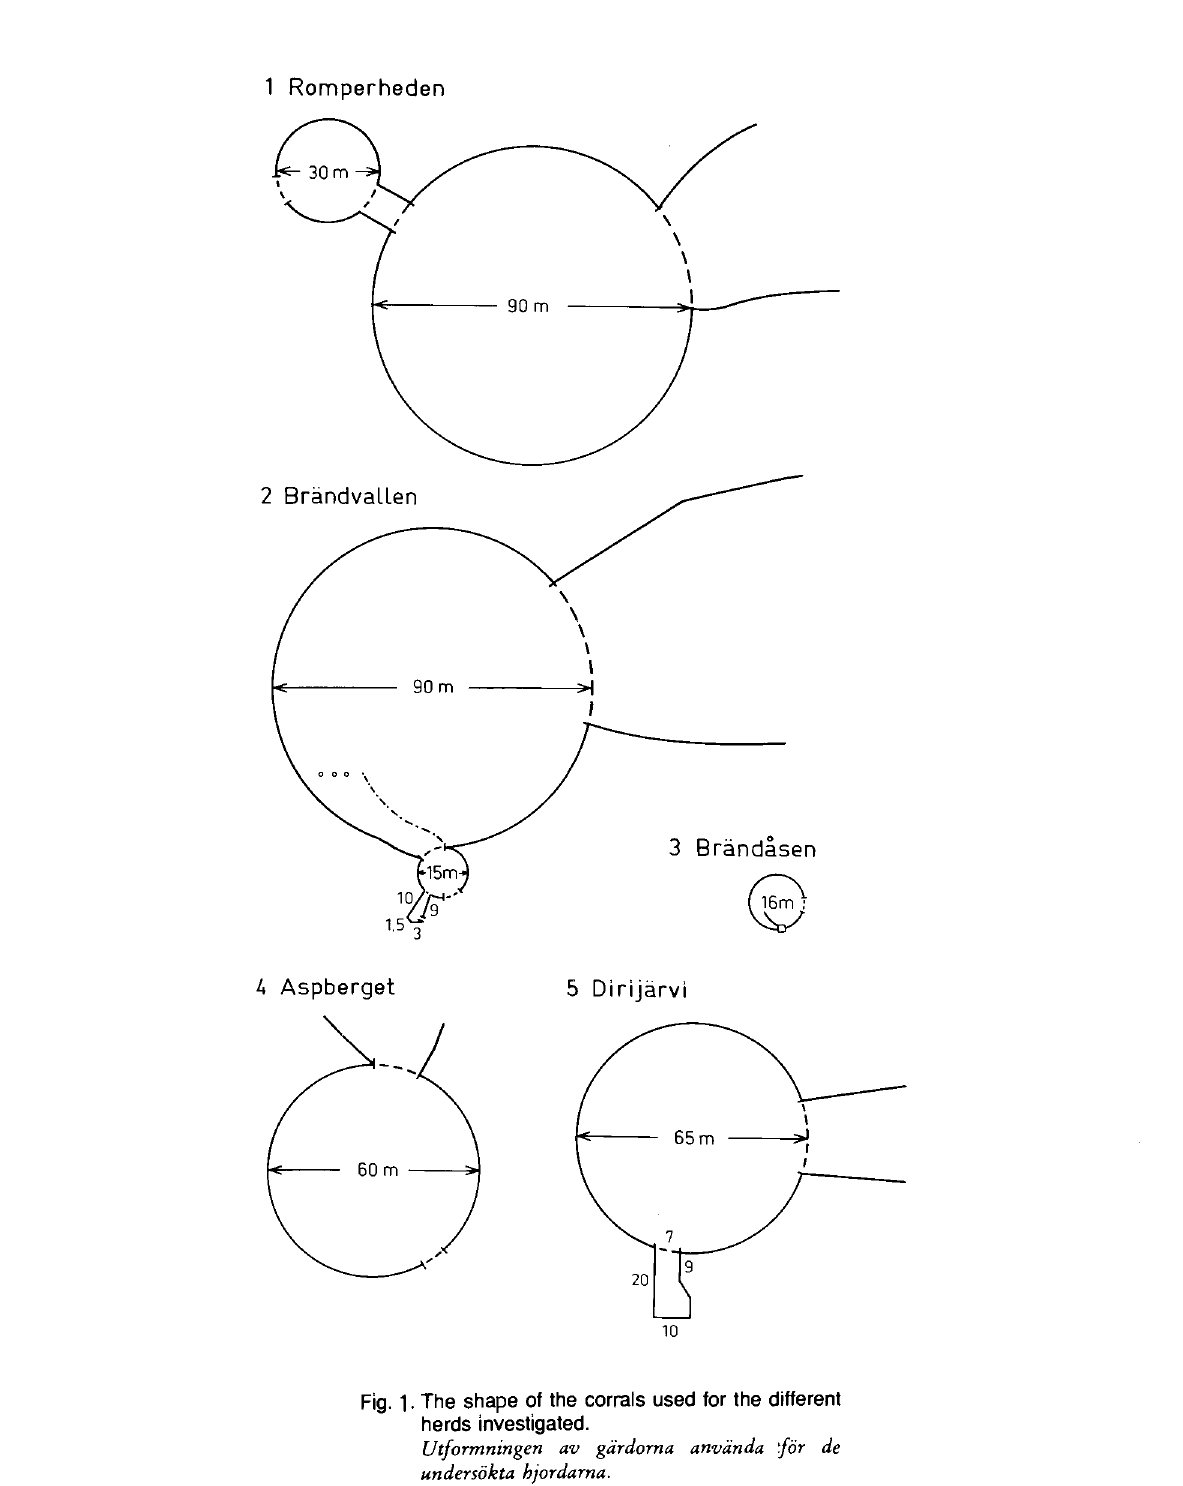
Fig. 1. The shape of the corrals used for the different herds investigated. Utformningen av gdrdorna anvanda for de undersokta